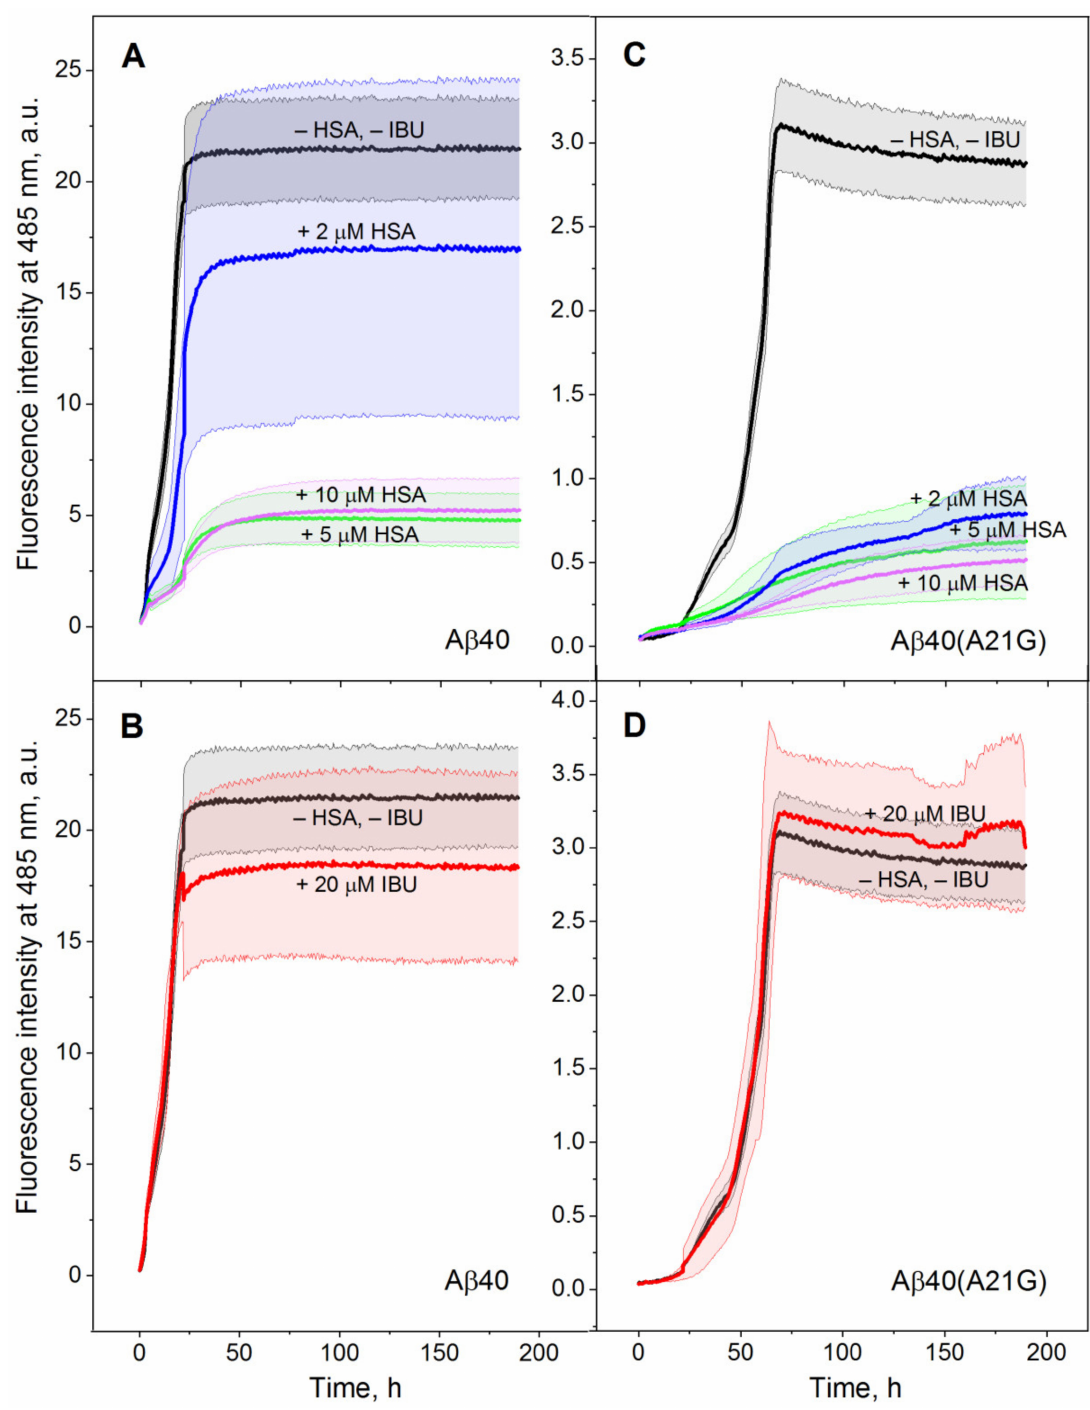
fibrillation process for 20 µ M A β 40 /A β 40 (A21G) in the absence/presence of 2–10 µ M HSA (corresponds to HSA level in cerebrospinal fluid of 3 µ M [10]) or/and 20 µ M IBU (close to therapeutic IBU level [43,44]) at 30 ◦ C was followed by fluorescence of 10 µ M ThT for 190 h (Figures 2 and 3).